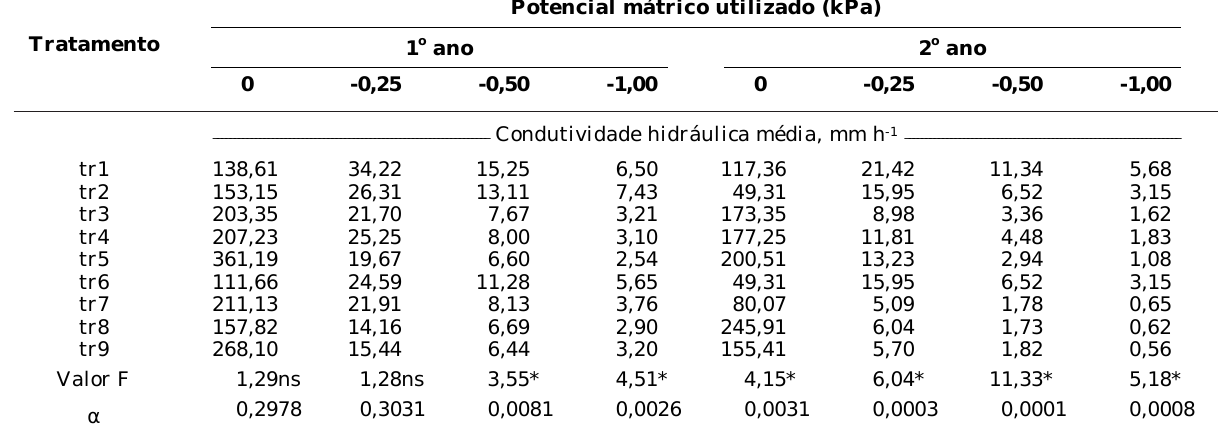
Quadro 1. Condutividade hidráulica correspondente a cada valor de potencial mátrico utilizado no infiltrômetro de tensão, nos dois anos do experimento: média por tratamento; valor F da análise de variância e respectivo nível de probabilidade